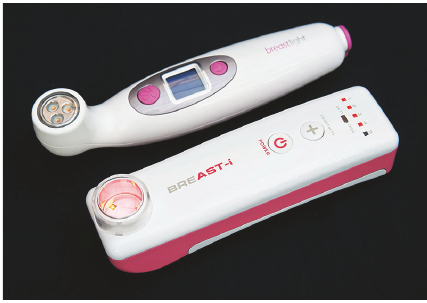
Figure 1: Breast-i and BreastLight . Breast-i when fully charged can be used to examine the breasts of about 70 women making it useful and accessible in areas with unreliable electricity. Usage requires just a dark room and a well-trained handler; hence it is inexpensive to use. Breast-i is equipped with five adjustable light intensities that enable usage on various skin tones, breast sizes and densities, and pregnant and lactating women. The advance sensor technology also protects the eyes of